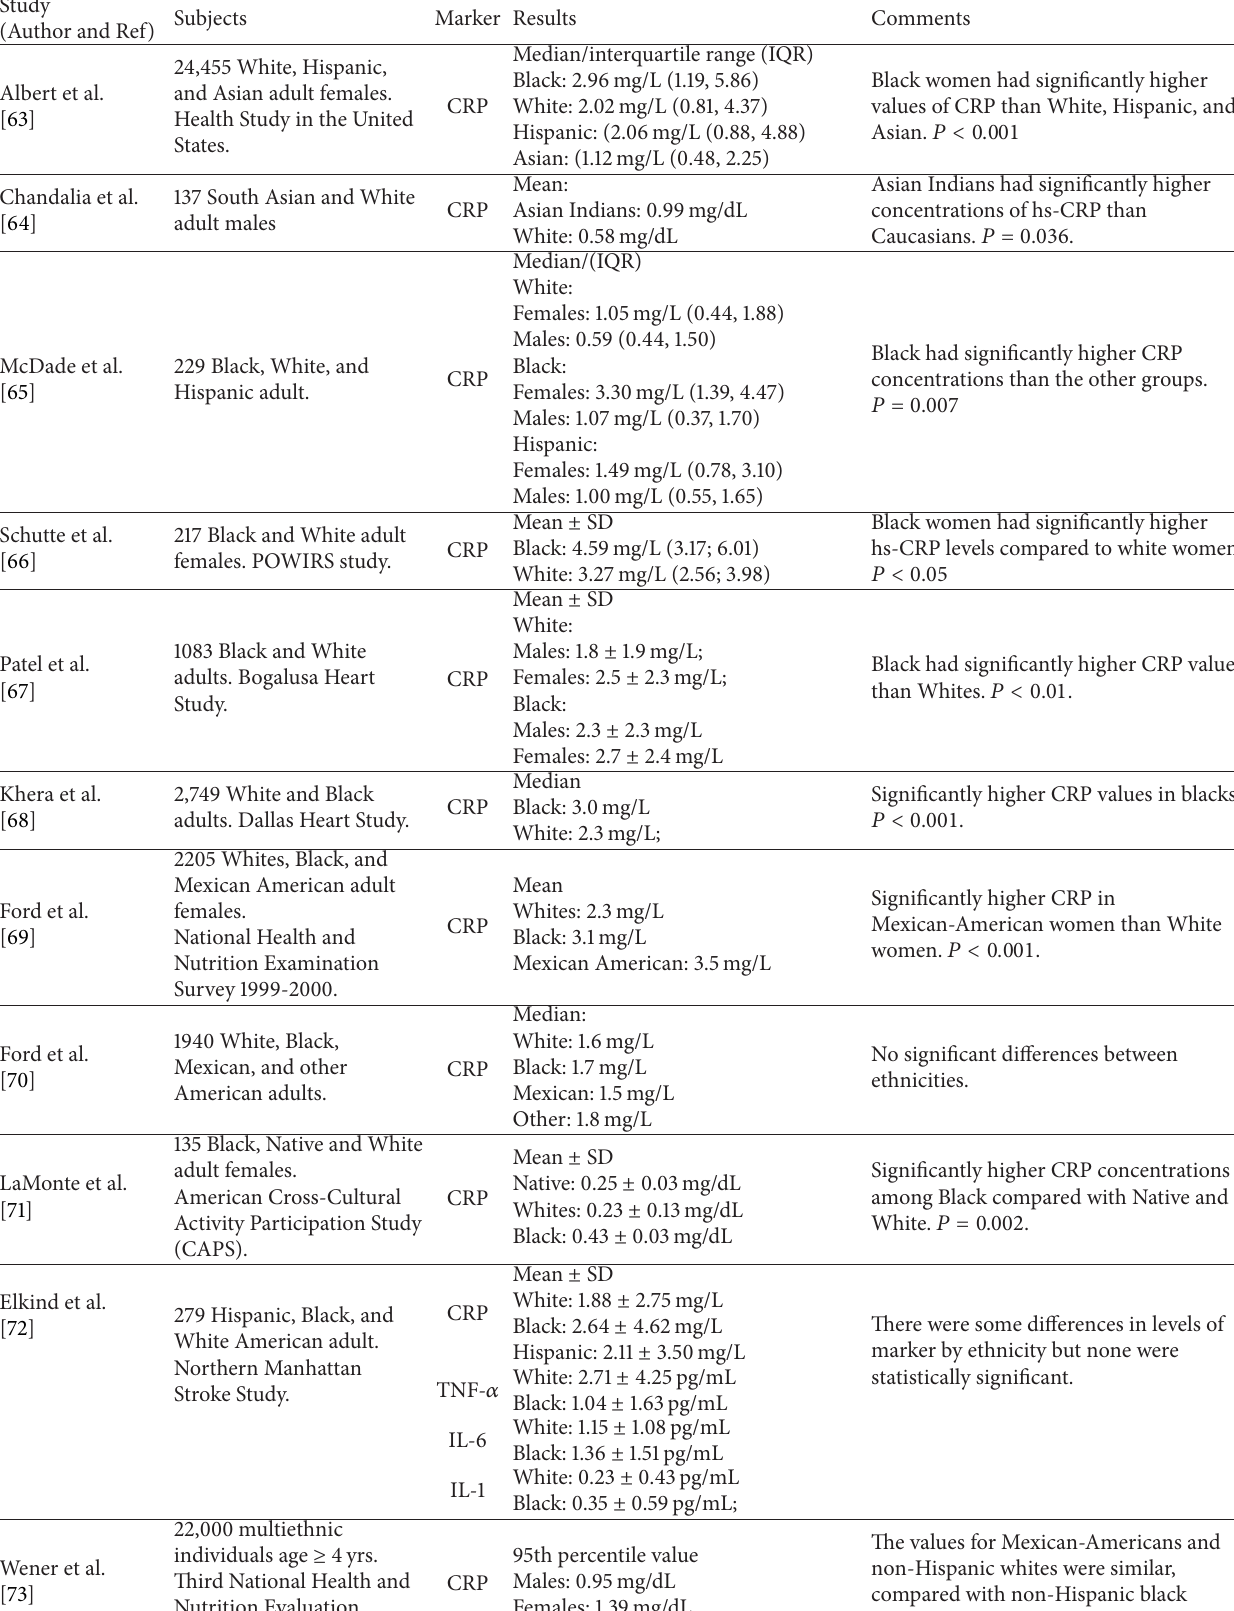
Table 2: Ethnic differences in main pro-inflammatory cytokines.